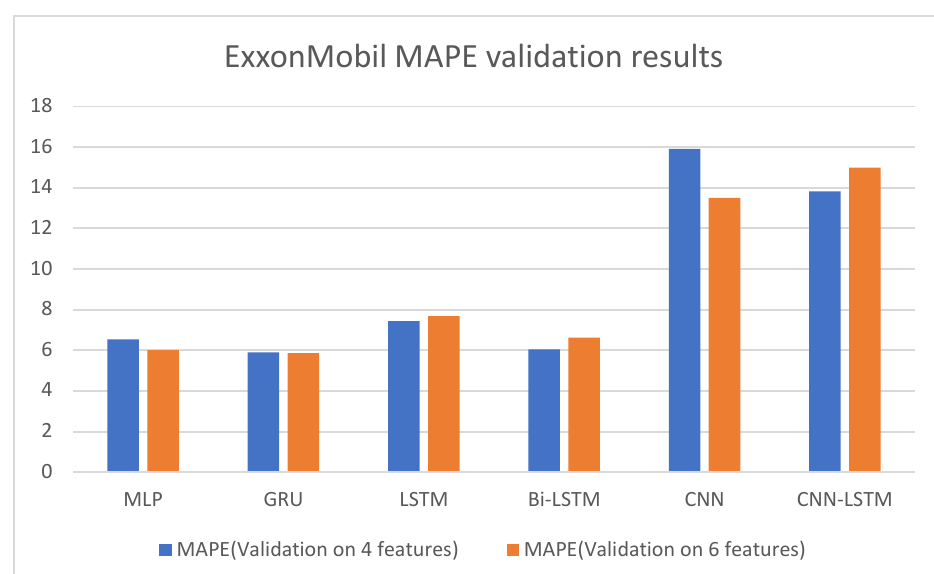
Figure 12. The visualization of the MAPE results of ExxonMobil .